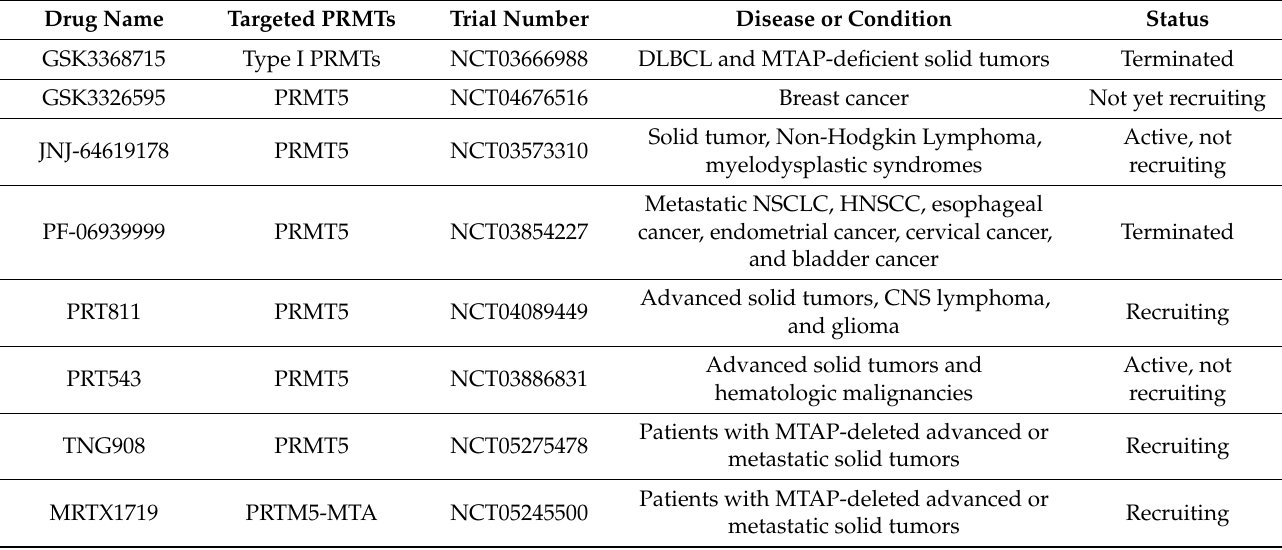
Table 1. PRMT inhibitors in clinical